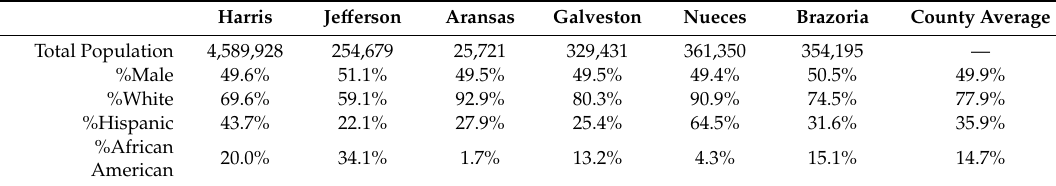
Table A1. Demographic breakdown for sampled counties 1